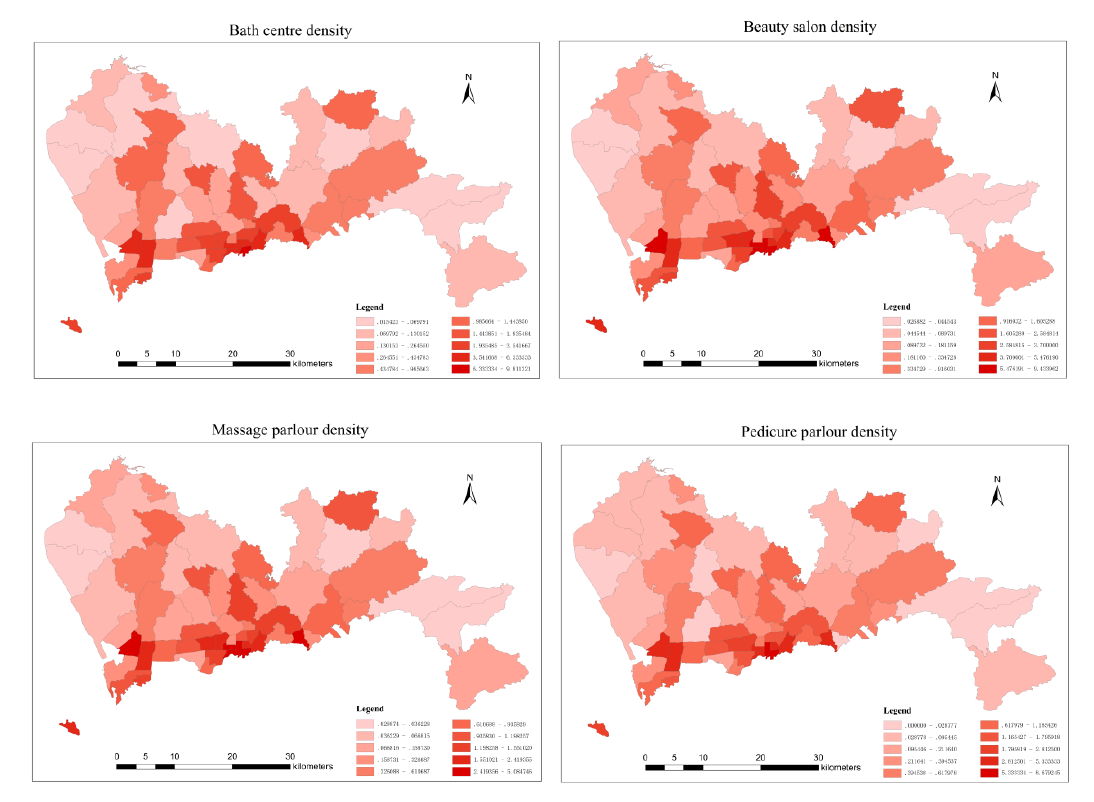
Figure 6. The spatial distribution density of the four types of service facilities.